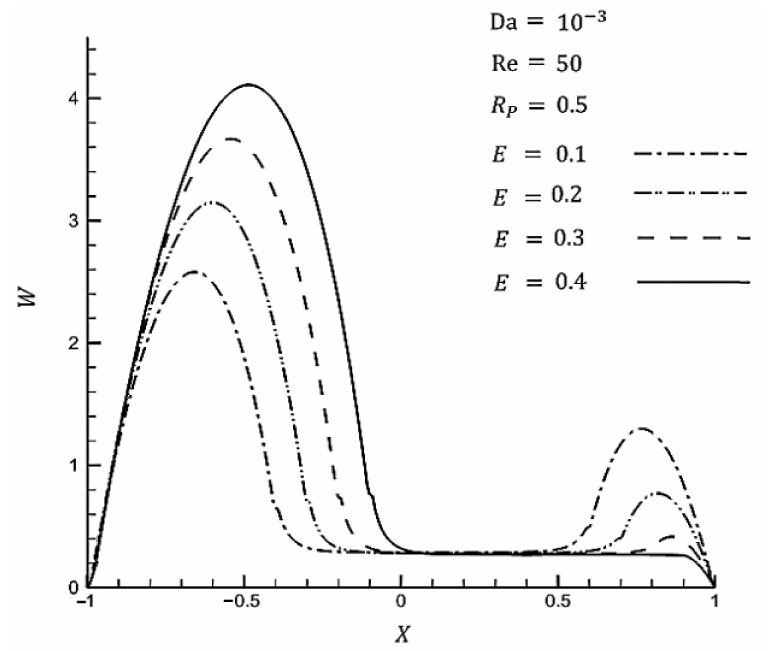
Figure 16. Effect of porous medium eccentricity on fully developed velocity profile.